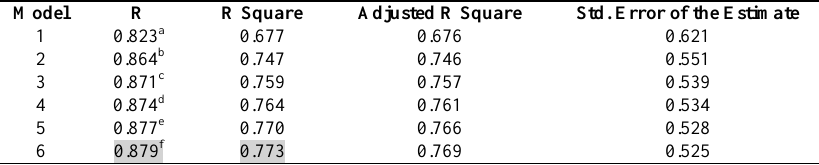
Table 4. Trend of determination coefficient